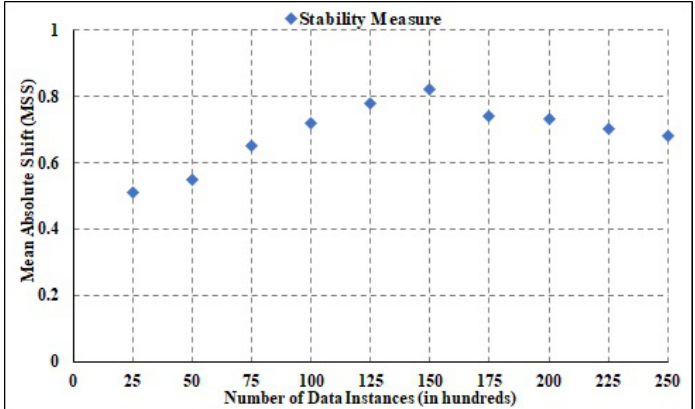
Figure 13. Stability